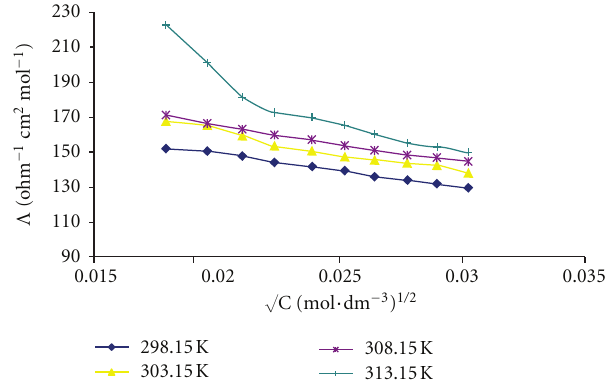
F 4: Molar conductance versus square root of concentration for Mg-succinate at different